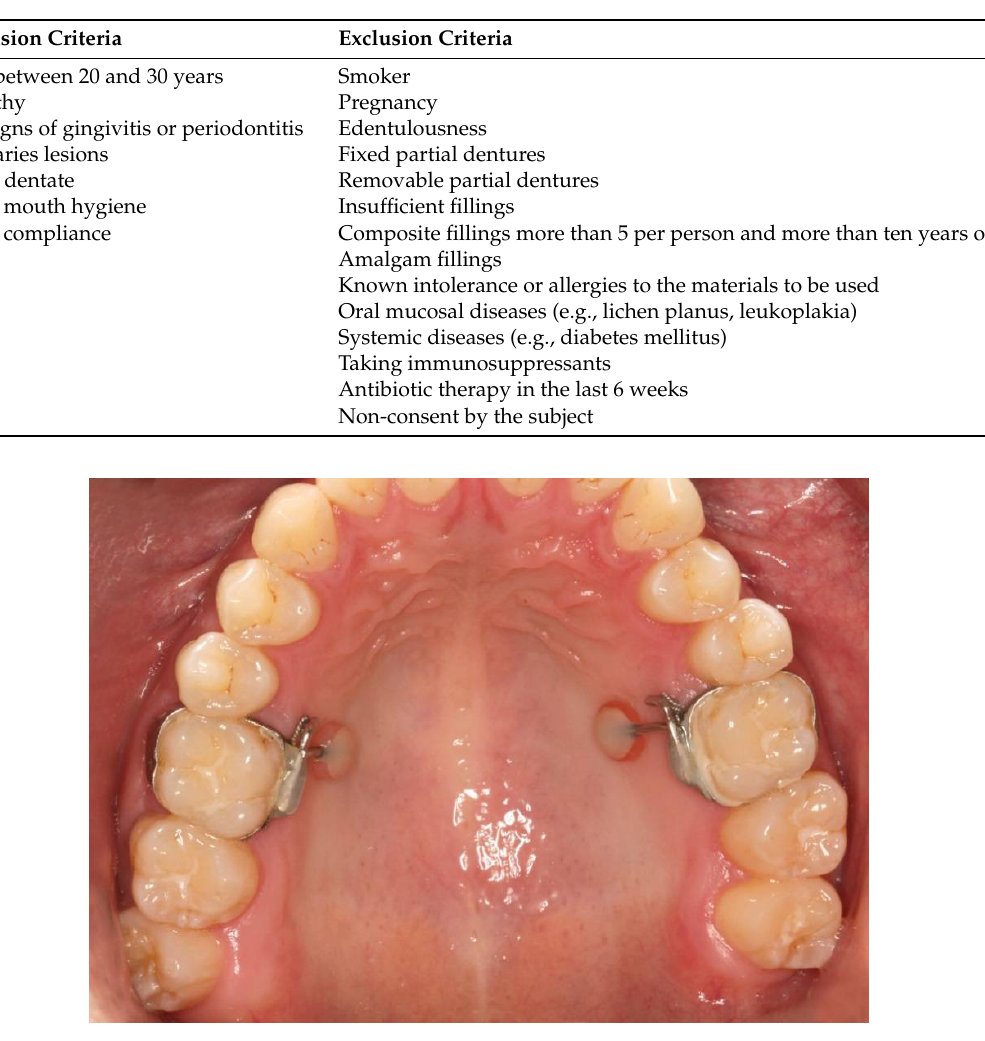
Table 1. Inclusion and exclusion criteria.